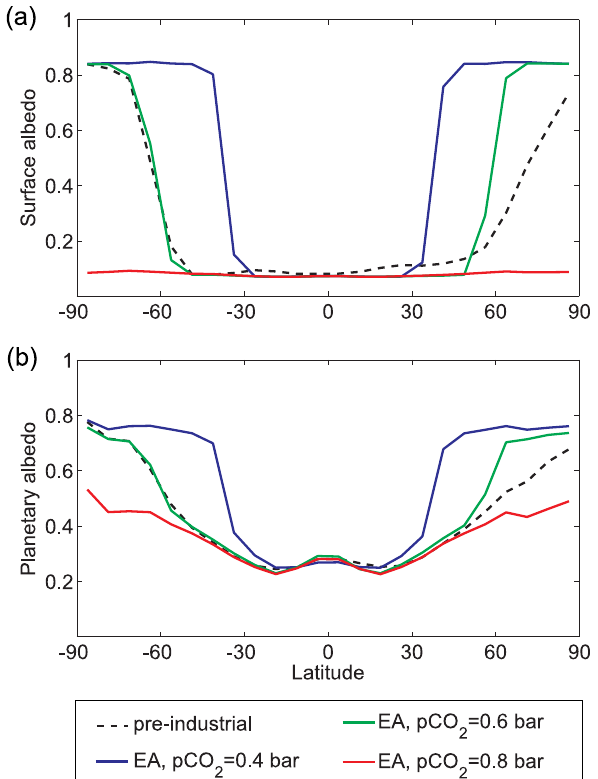
Fig. 7: Annual and zonal mean surface and planetary albedo for the following states: pre-industrial (black), the critical state of the early Archean ( p CO 2 =0.4bar, blue), the state of the early Archean with present-day mean SAT of 288K ( p CO 2 =0.6bar, green) and an ice-free state ( p CO 2 =0.8bar, red).